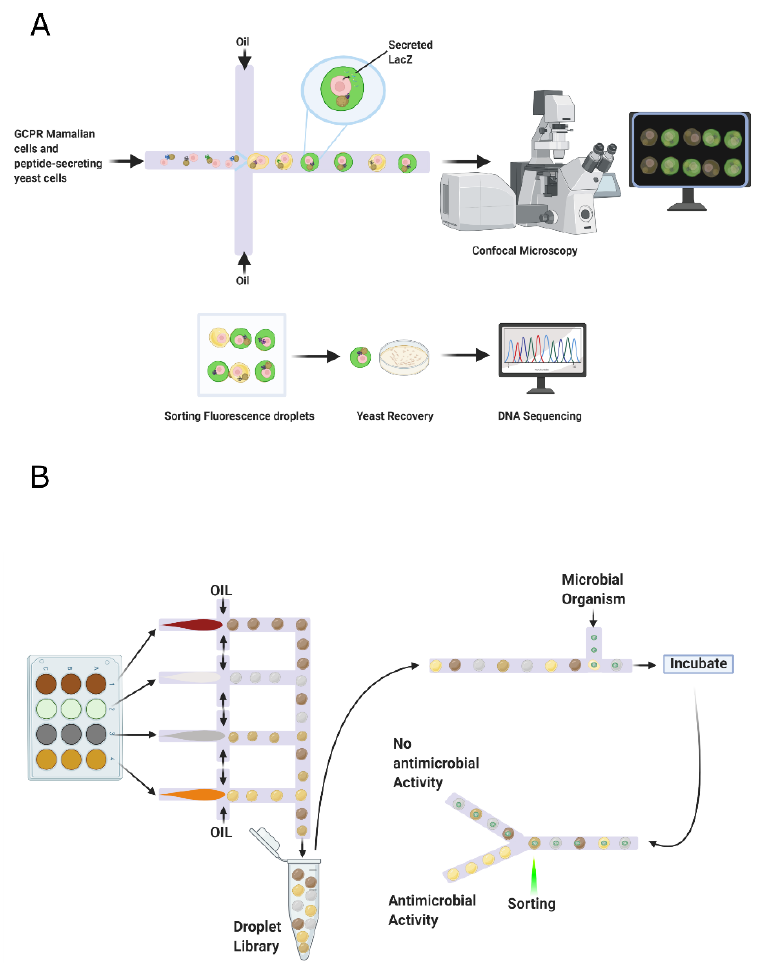
Figure 7. Droplet-based microfluidics screening strategies. ( A ) Schematic of screening performance used by Yaginuma where cells and peptide secreting yeast are encapsulated in a droplet system. Droplets with fluorescence due to the secretion of LacZ are sorted and recovered for yeast culture. Finally, peptides secreted are sequenced to obtain functional candidates. ( B ) Schematic of screening performance used by Guo where a droplet library is generated using a microfluidic approach. The antimicrobial activity analysis is carried out injecting the droplets in a microfluidic platform where single microbial cells are added and incubated. Finally, the droplet-encapsulated compounds are screened and sorted based on the microbial growth arrest (Created with BioRender).